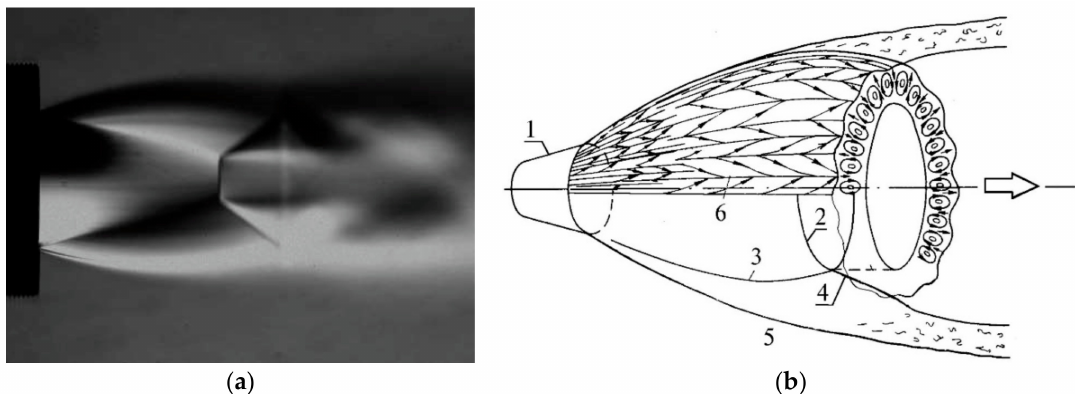
Figure 2. Schlieren photo ( a ) of a supersonic underexpanded jet (N pr = 5.0) exhausted from a convergent nozzle with a small value of surface roughness, and a diagram ( b ) of streamwise vortical structures formed in the jet mixing layer: 1—nozzle; 2—Mach disk; 3,4—barrel and reflected shocks; 5—mixing layer; 6—streamwise vortices.